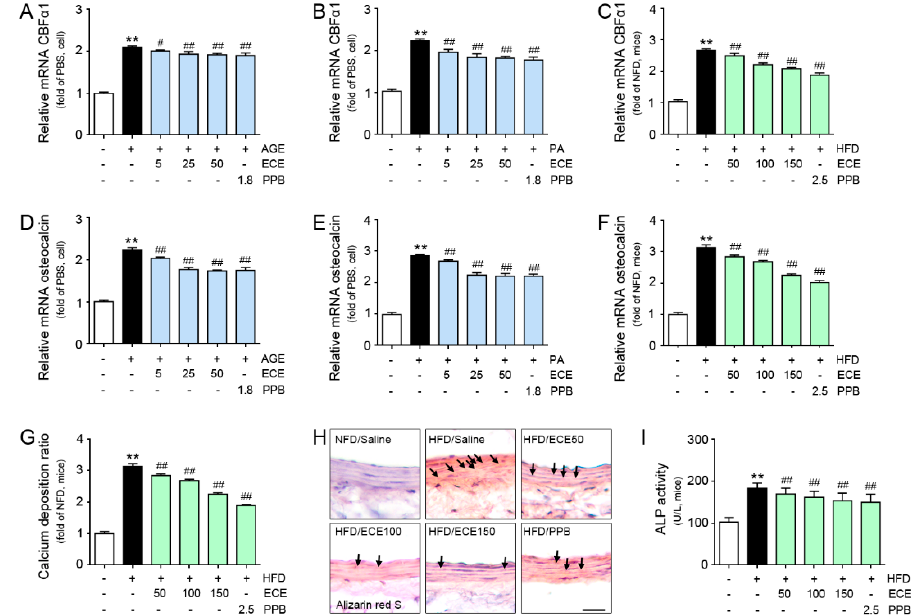
Figure 4. Comparative analysis of ECE and PPB treatment on the reduction of osteoblast-like cell marker expression in AGE or palmitate-treated VSMC and HFD-fed mice. ( A – C ) mRNA levels of the osteoblast-like markers CBF α 1 in AGE- or PA-treated VSMC (cell) and HFD-fed mice were determined by qRT-PCR. ( D – F ) mRNA levels of the osteoblast-like markers osteocalcin in AGE- or PA-treated VSMC (cell) and HFD-fed mice were determined by qRT-PCR. ( G ) Calcium deposition was calculated using the calcium deposition assay and ( H ) Alizarin red S staining in HFD-fed mice. Positive signal (red dot, arrow) was marked with an arrow in images. Scale bar = 50 µ m. ( I ) ALP activity was measured with the use of the aorta of HFD-fed mice. **, p < 0.01 vs. PBS or NFD / Saline group; #, p < 0.05, ##, p < 0.01 vs. AGE, PA or HFD / Saline group. AGE, advanced glycation end products; ALP, alkaline phosphatase; CBF α 1, core-binding factor alpha 1; ECE, Ecklonia cava extract; HFD, high-fat diet; NFD, normal fat diet; PA, palmitate; PBS, phosphate-bu ff ered saline; PPB, pyrogallol-phloroglucinol-6,6-bieckol; qRT-PCR, real-time quantitative reverse transcription polymerase chain reaction; VSMC, vascular smooth muscle